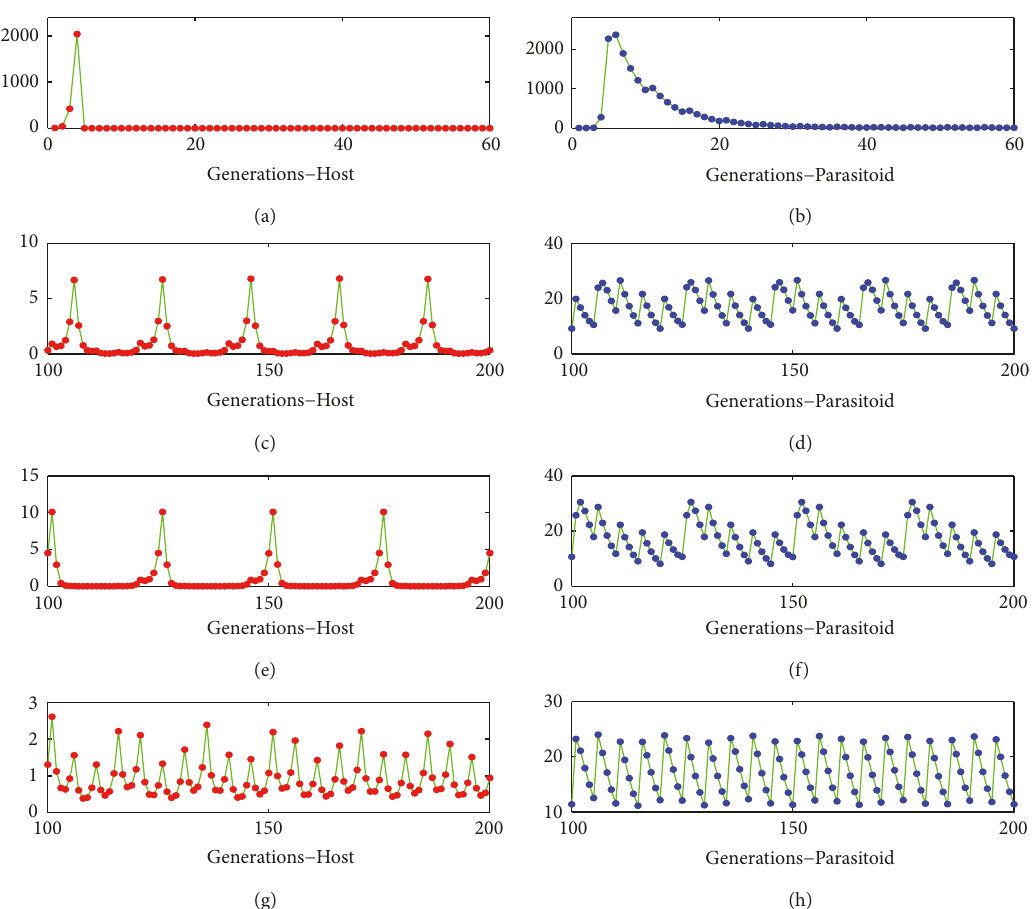
Figure 6: Fourcoexistingattractorsof model(3). Parametersare 𝑟 = 2.63 , 𝑎 = 0.15 , 𝑞 𝑚𝑎𝑥 1 = 0.2 , 𝜎 = 0.8 , 𝜃 1 = 0.0001 , 𝑞 𝑚𝑎𝑥 2 = 0.3 , 𝜃 2 = 0.00005 , 𝜏 = 10 , 𝑞 = 5 . The initial densities from top to bottom are (3.01,0.99),(0.93,20), (10.02,25.81),(1, 25) ,